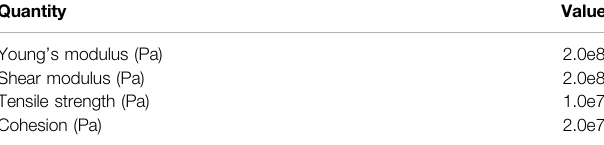
TABLE 2 | Interparticle bond properties of rock layers for DEM simulation. Quantity